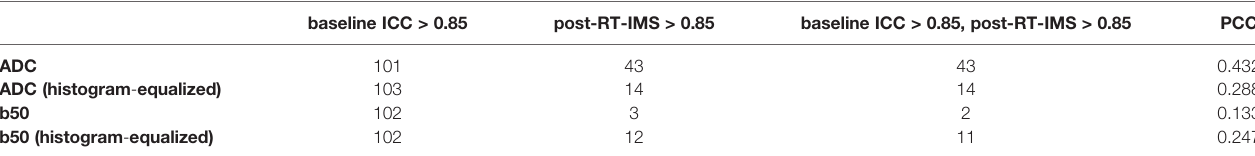
TABLE 1 | Repeatability